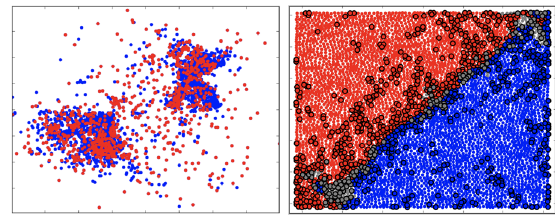
Figure 5. Failure regime. Scatter plot of displacements in DSS at the axial strain interval of [0.0388,0.0392] (left): here nodes highlighted in red correspond to those grains with the highest ro- tations (top 20%) which are mainly in the shear band. Member nodes of the di ff erent components in G ( r ) just before explosive percolation S ( r max( γ ) − δ ), mapped back into the physical domain of the sample: members of the largest and second largest con- nected components are colored red and blue, respectively, with the rest in grey (right). Grains with the highest rotations are high- lighted by the black outlined circles.